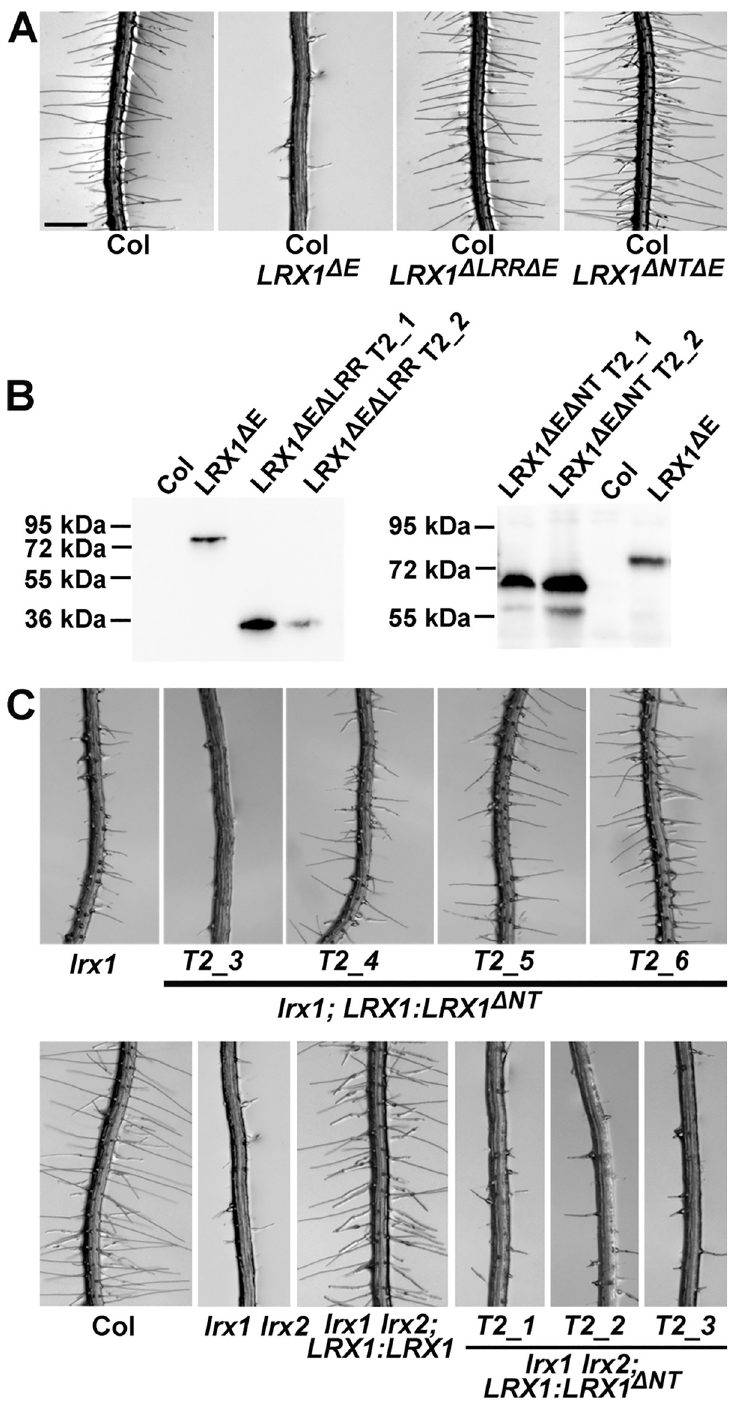
Fig 4. Both the LRR and NT domains are required for function of LRX1. (A) Root-hair phenotype of wild type seedlings (Col) or transgenic Col lines expressing LRX1 Δ E , LRX1 Δ LRR Δ E , or LRX1 Δ NT Δ E (for protein structures, see Fig 1A). The dominant-negative effect induced by LRX1 Δ E depends on both the LRR and the NT domains. A representative example of several independent transgenic lines is shown. (B) Immunoblots using the anti-cMyc antibody 9E10 detecting the proteins encoded by the transgenic lines shown in (A). (C) In the absence of the NT domain ( LRX1 Δ NT ) complementation of lrx1 gives variable phenotypes (upper lane) and no complementation of lrx1 lrx2 is observed. An immunoblot showing LRX1 Δ NT accumulation in the different lines is shown in S5 Fig. Bar = 0.5 mm (A, C).